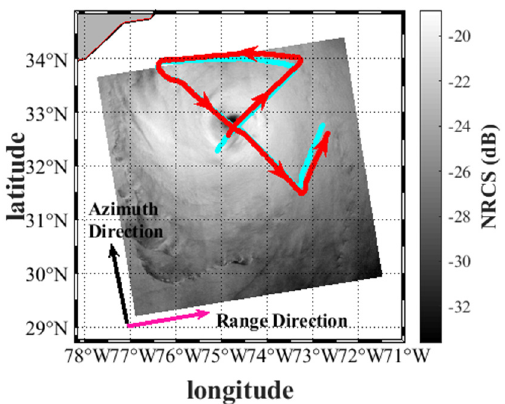
Figure 1. The RS-2 SAR image of TC Earl on 2 September 2010, at 22:59:14 UTC. The black and pink arrows denote the azimuth and range directions of the SAR image, respectively. The blue line represents the original SFMR track, and the red line denotes the modified SFMR track by considering the TC’s movement.